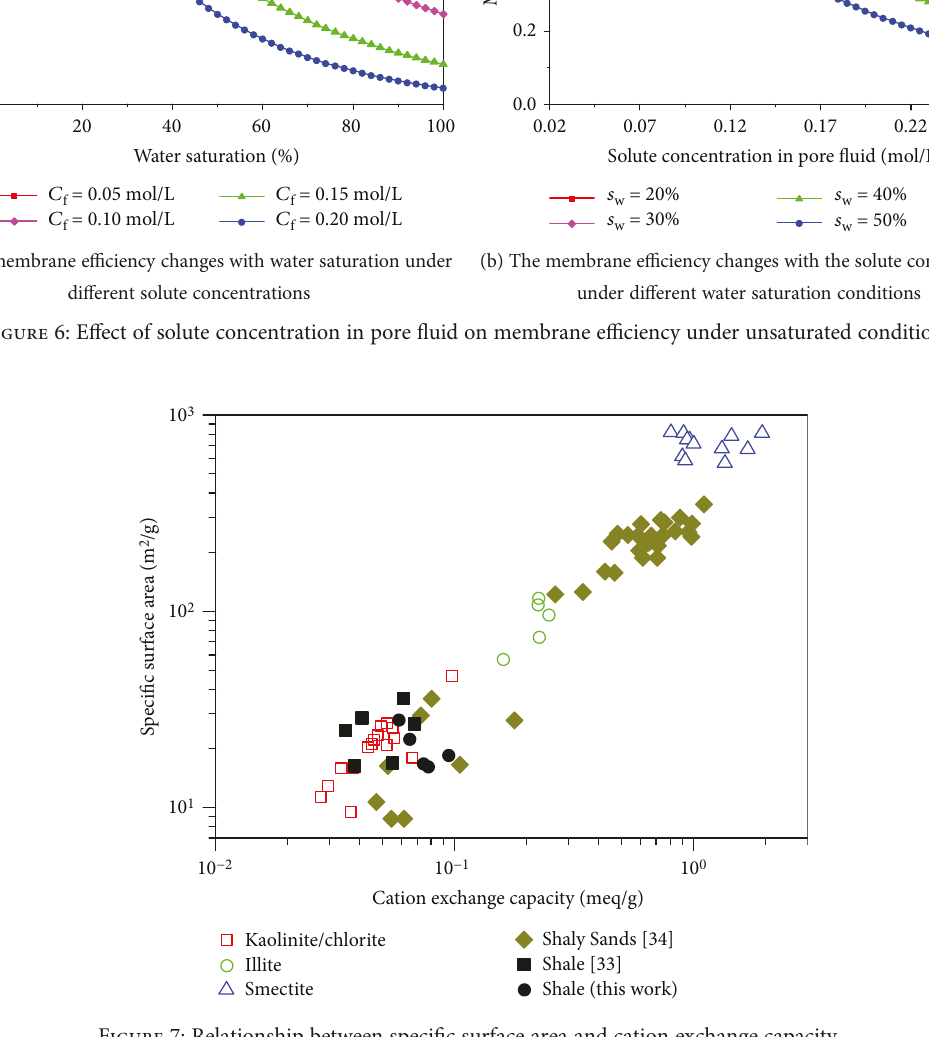
Figure 7: Relationship between speci fi c surface area and cation exchange